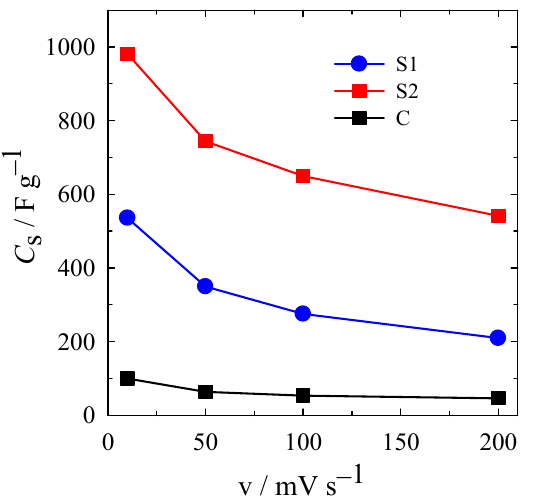
Figure 6. Specific capacitances of the sample S1, sample S2, and carbon obtained from CV curves.